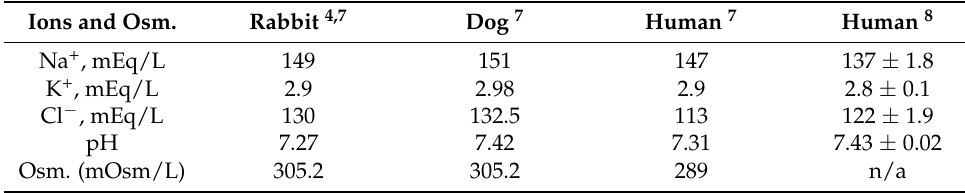
Table 2. The concentration of ions and osmolality in CSF from animals. Ions and